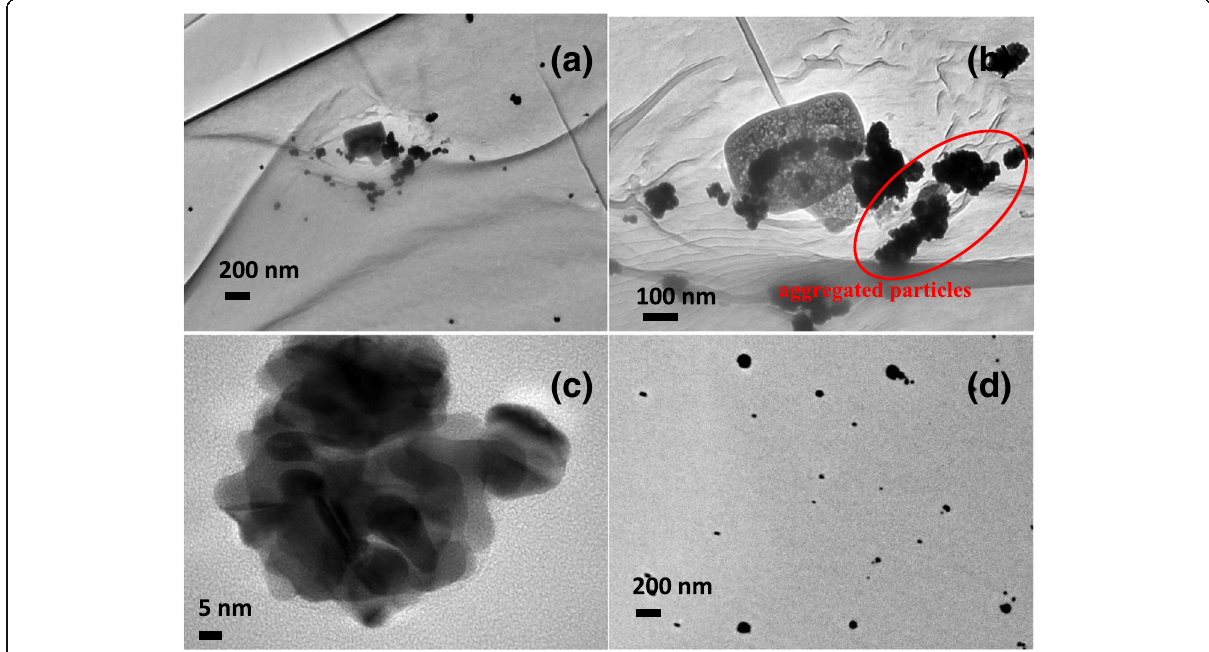
Fig. 7 TEM images of GNPs ( a ), ( b ) and ( c ) aggregated particles in 80% volumetric percentage of ethanol ( d ) discrete particles in 100%